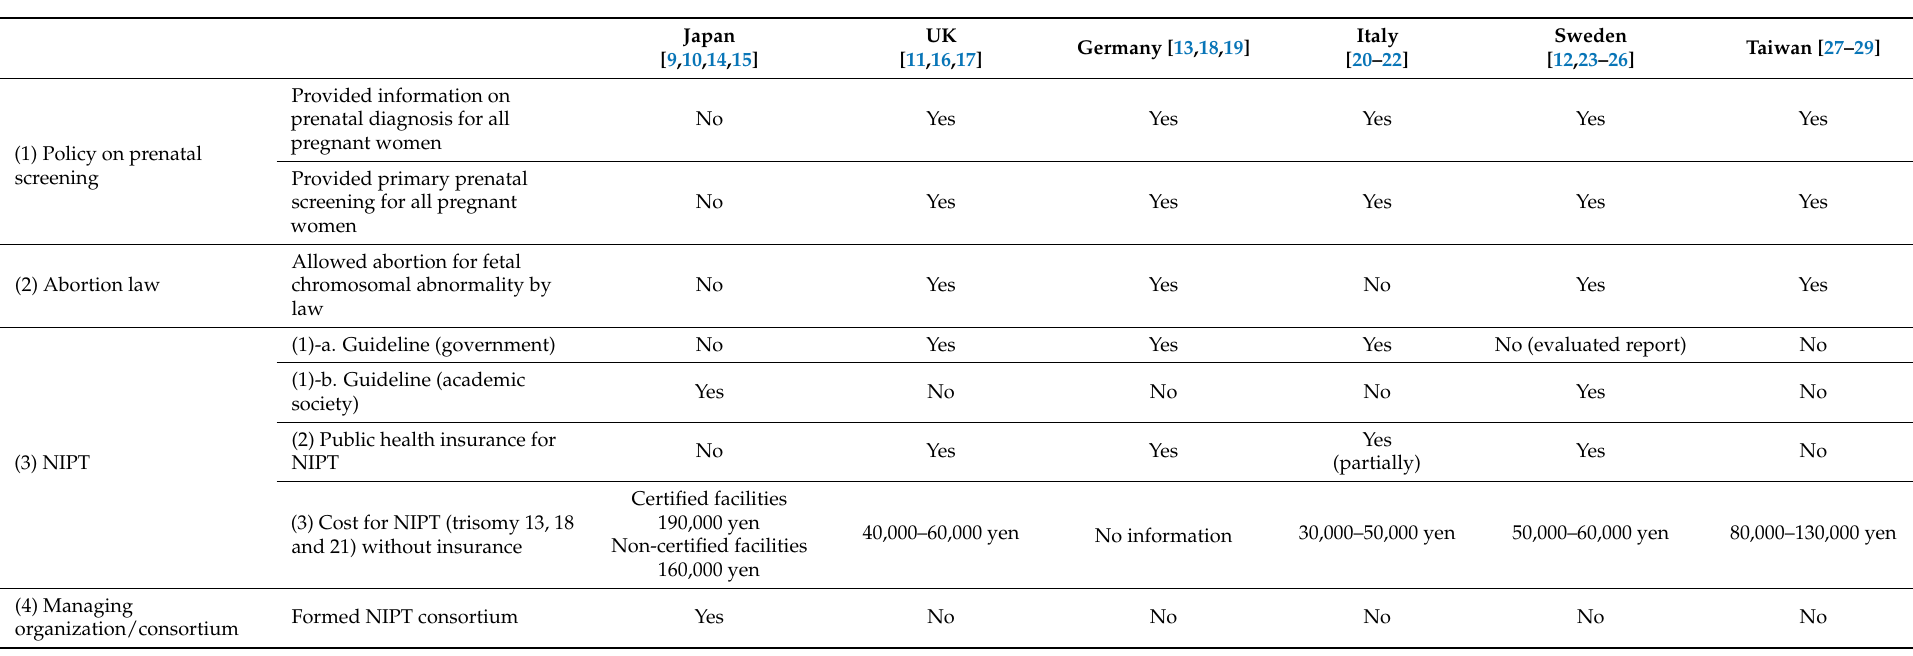
Table 1. Summarized characteristics of country